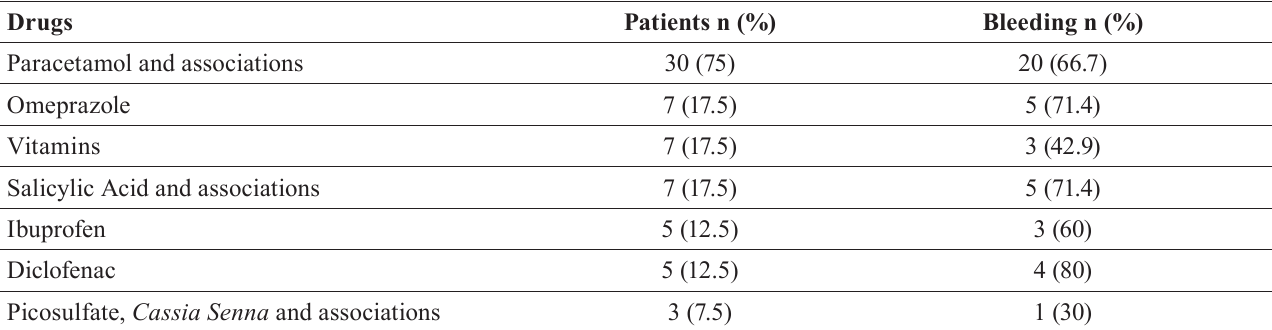
TABLE III - Frequency of self-medication with drugs that increase the risk of bleeding among users of warfarin. Ijuí/Brazil n =